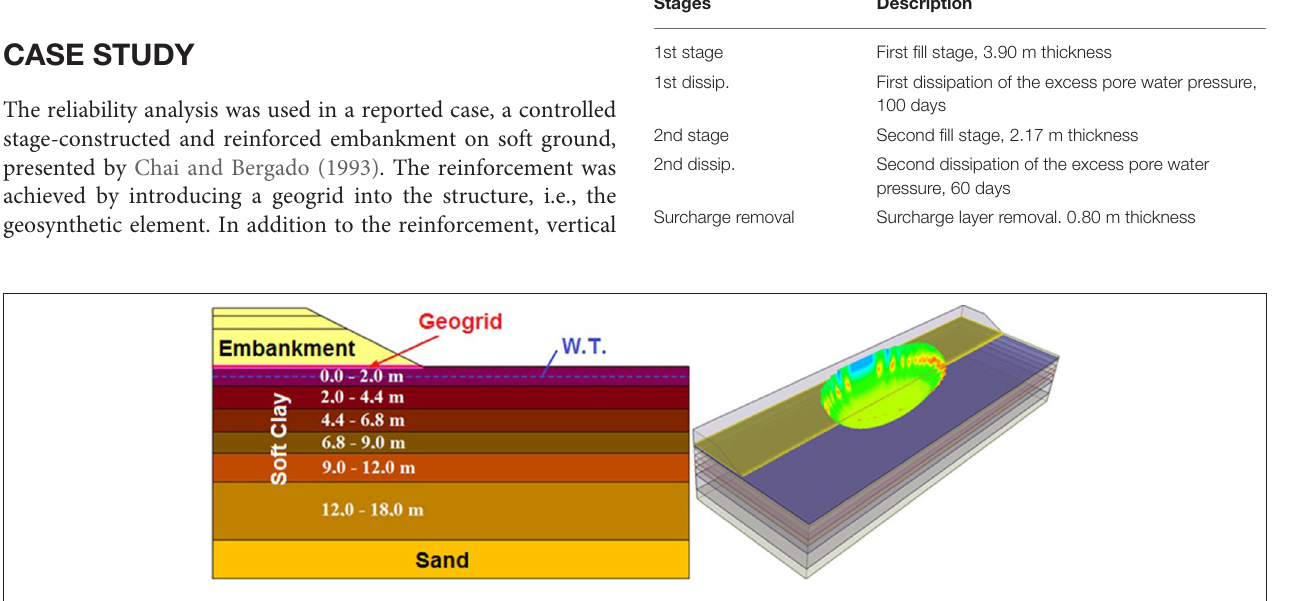
FIGURE 1 | Embank geometry (model via GeoStudio and